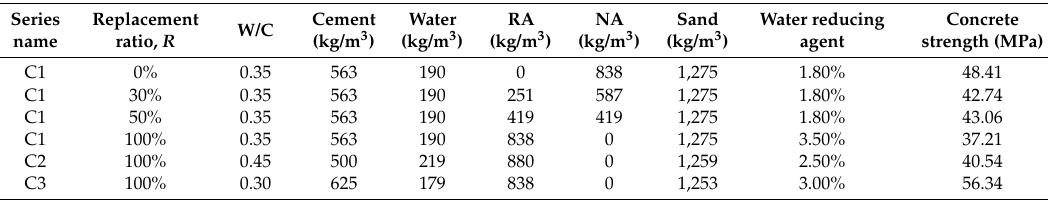
Table 3. Mix proportions of RAC (recycled aggregate concrete) (kg/m 3 ).